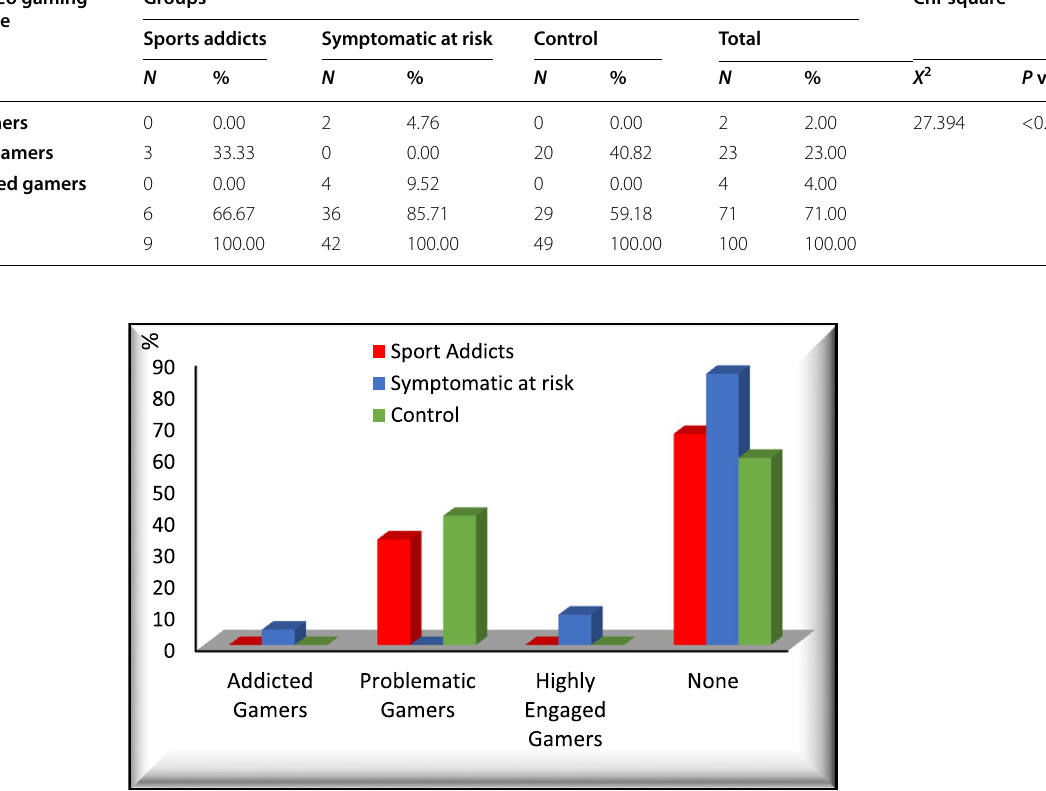
Table 3 Video Gaming Addiction Scale among sports addicts and control Results of video gaming addiction scale